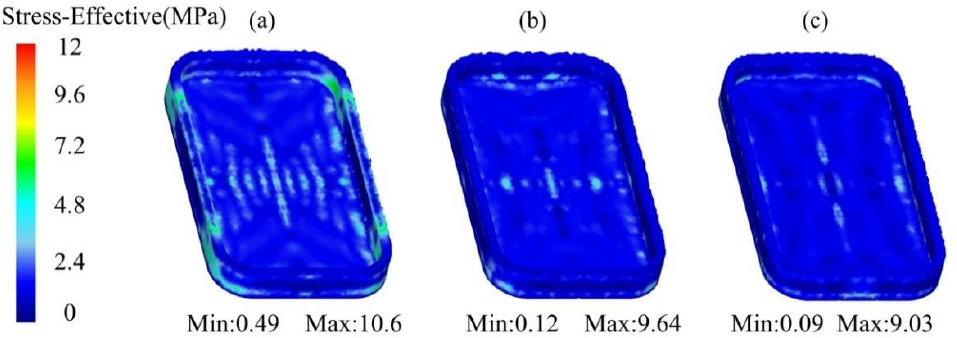
Figure 7. Equivalent stress distribution of the mobile phone shell at the billet temperatures of ( a ) 625°C, ( b ) 630°C, and ( c ) 635 °C.